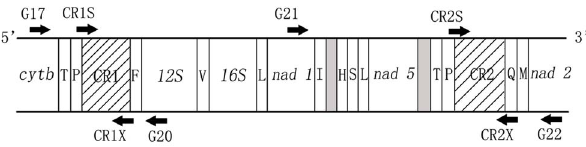
Figure 1. Locations of duplicate CRs and primers used for amplification. G17/G20 are outer primers for CR1; G21/G22 are outer primers for CR2. These primer pairs were used to determine the presence of CRs in the mtDNA of individual turtles. Inner primers, CR1S/ CR1X and CR2S/CR2X, are designed to amplify specific duplicate CRs. The names of tRNA genes are shown using abbreviations of amino acids (T: tRNA Thr , P: tRNA Pro , F: tRNA Phe , V: tRNA Val , L: tRNA Leu , I: tRNA Ile , H: tRNA His , S: tRNA Ser , Q: tRNA Gln , M: tRNA Met ). Gray boxes represent non- coding spaces between two genes. CR1 and CR2 are indicated with